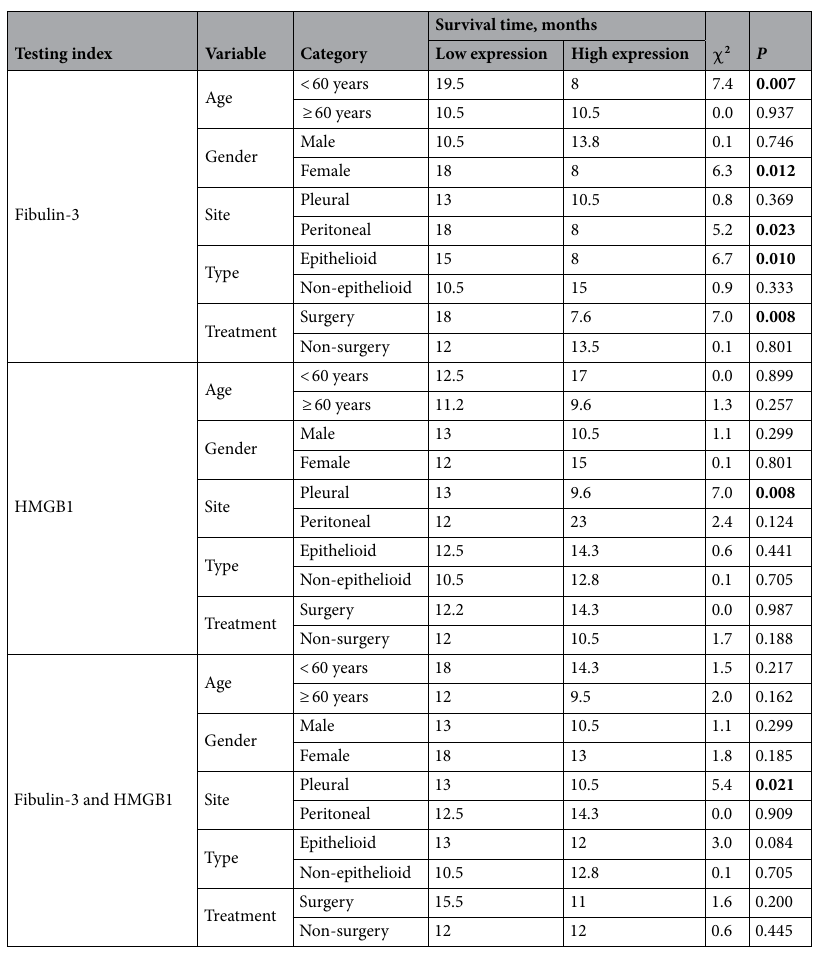
Table 3. Association between fibulin-3, HMGB1 expression and prognosis of mesothelioma within subgroups. The bold P value was <